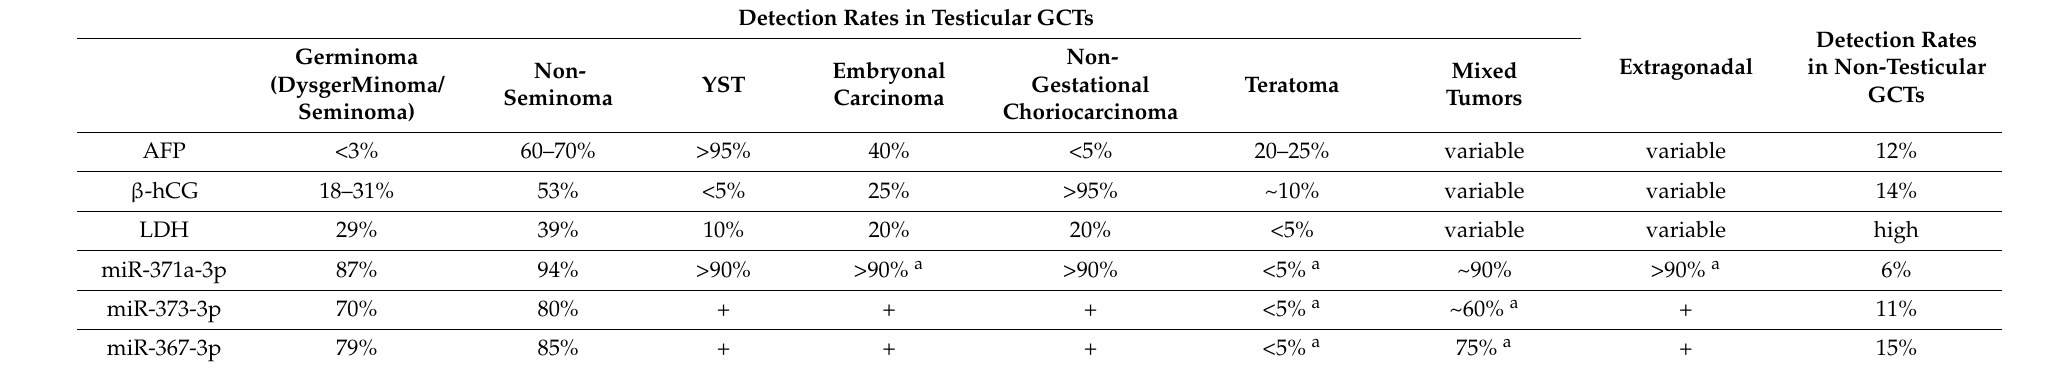
Table 3. Classic serum GCTs markers, miRNA-based markers and histological subtypes [Almstrup